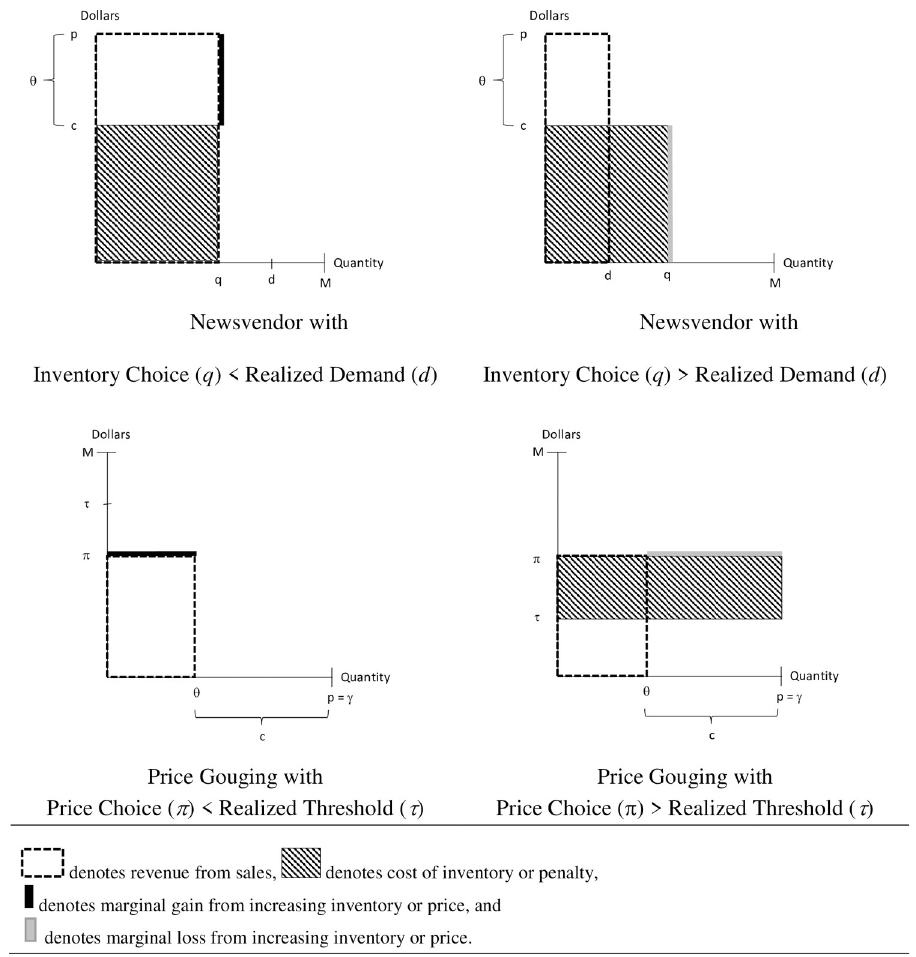
Fig 1. Comparison of newsvendor and price gouging